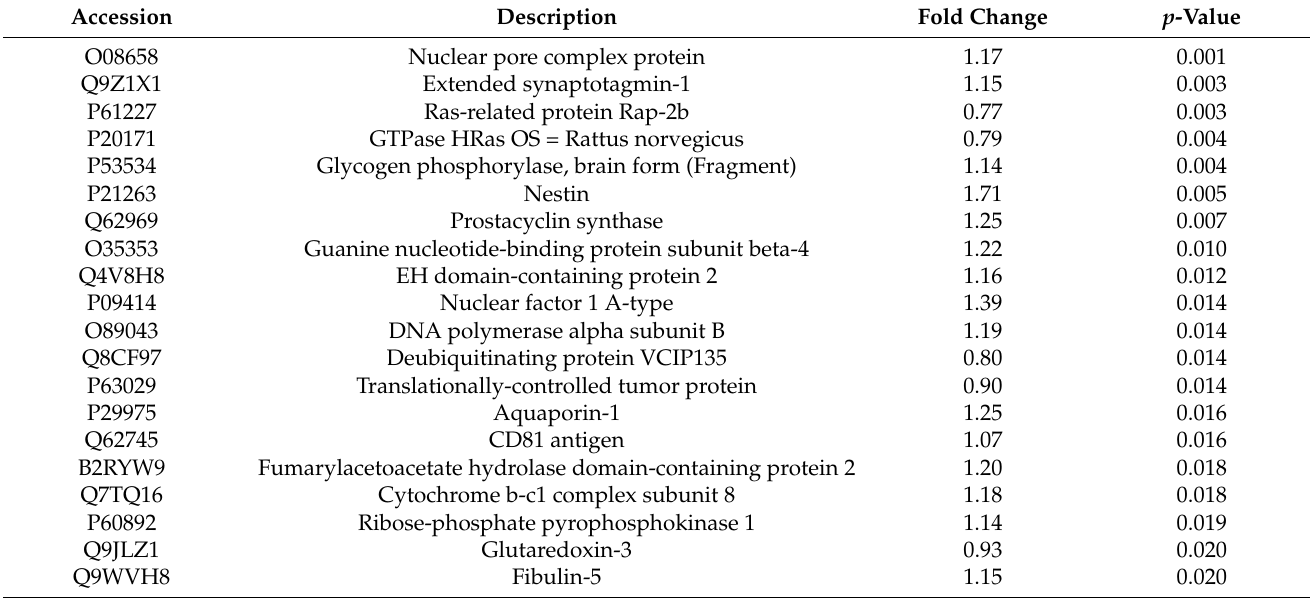
Table 2. Top Deregulated Proteins in CAG Treated AAA vs. Vehicle Treated